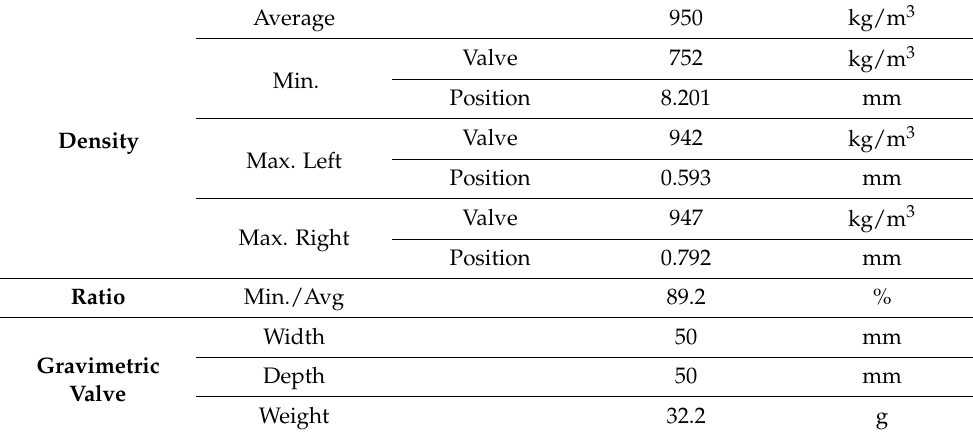
Table 23. Experimental data of